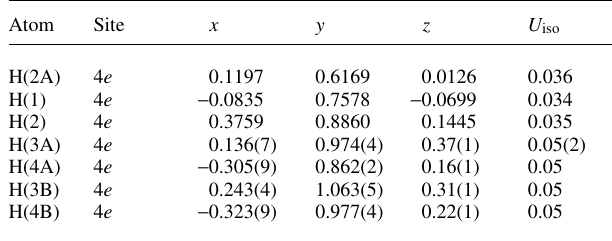
Table 2. Atomic coordinates and displacement parameters (in Å 2 ) .